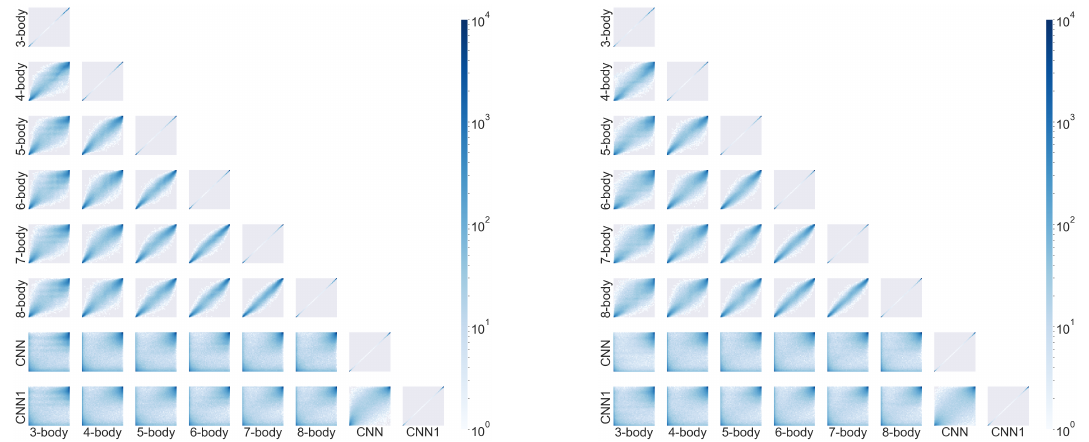
Figure 9: Correlation plots for top quark tagging without mass on the left and with ∈ [ 1300,1400 ] GeV. The weak correlation corresponds mass on the right, for p T